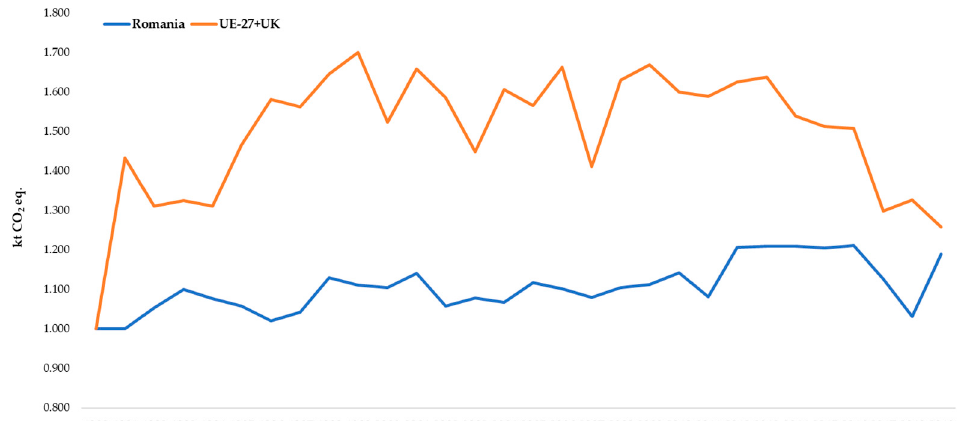
Figure 5. Net GHG removals dynamics comparative aspects, UK-27 + UK vs. Romania (1990 = 1). Net GHG removals had tendencies to increase at EU-27 + UK and Romania levels; Romania tended to have fewer fluctuations compared to the EU region. For EU-27 + UK, the average annual growth rate of 0.8%/year during the 1989–2019 time period is higher than the average annual growth rate recorded by Romania, at +0.6%/year (Figure 6).